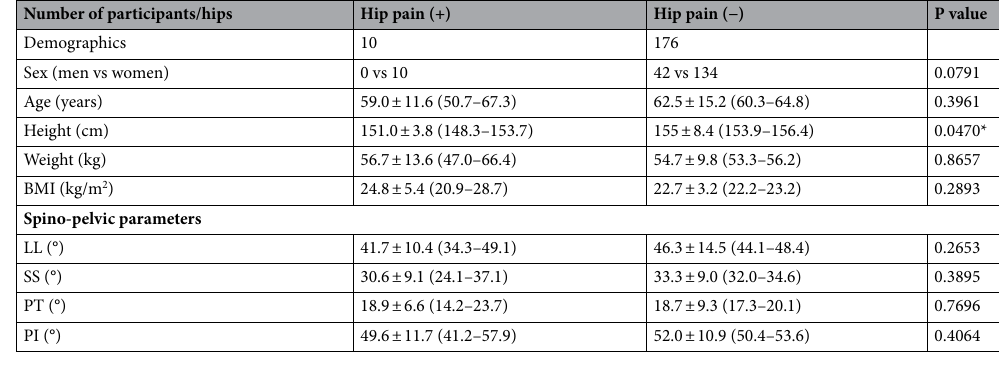
Table 4. Comparison of the demographics and spino-pelvic parameters between the groups with and without hip pain in participants with acetabular dysplasia. Results are presented as mean ± standard deviation